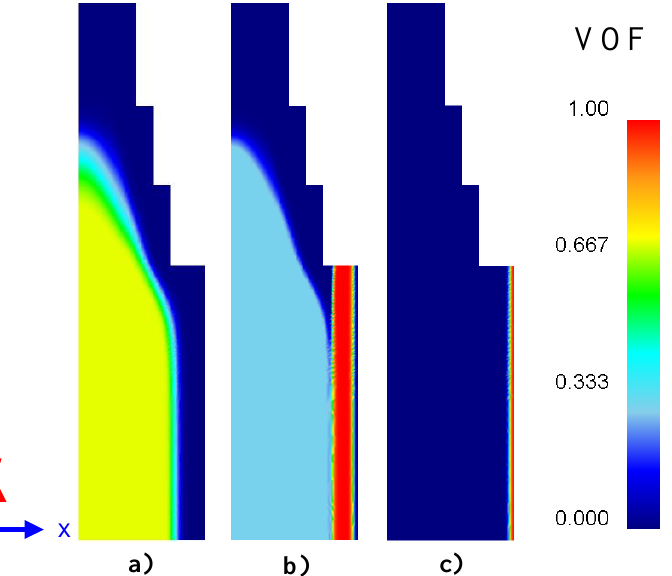
Figure 6. Cloud diagram of microstructure distribution after spray cooling. ( a ) Pearlite; ( b ) bainite; ( c ) martensite.